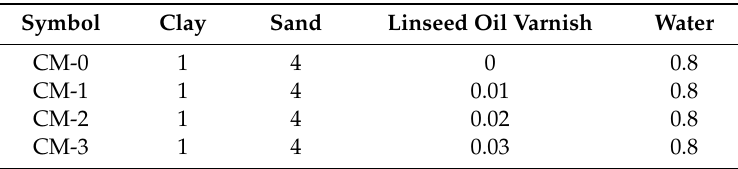
Table 1. Recipes of mortars (weight ratios in relation to clay) .